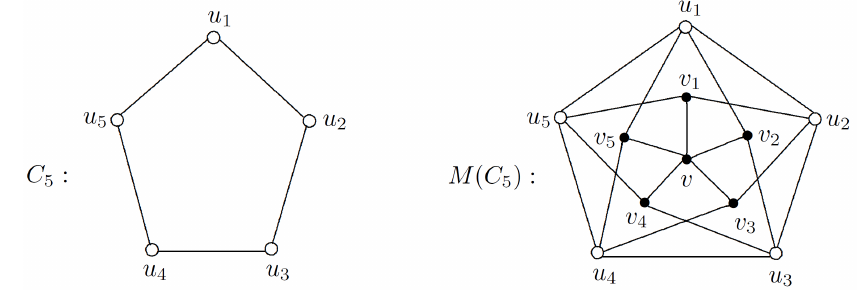
Figure 6: The graphs C 5 and Gr¨otzsch graph.